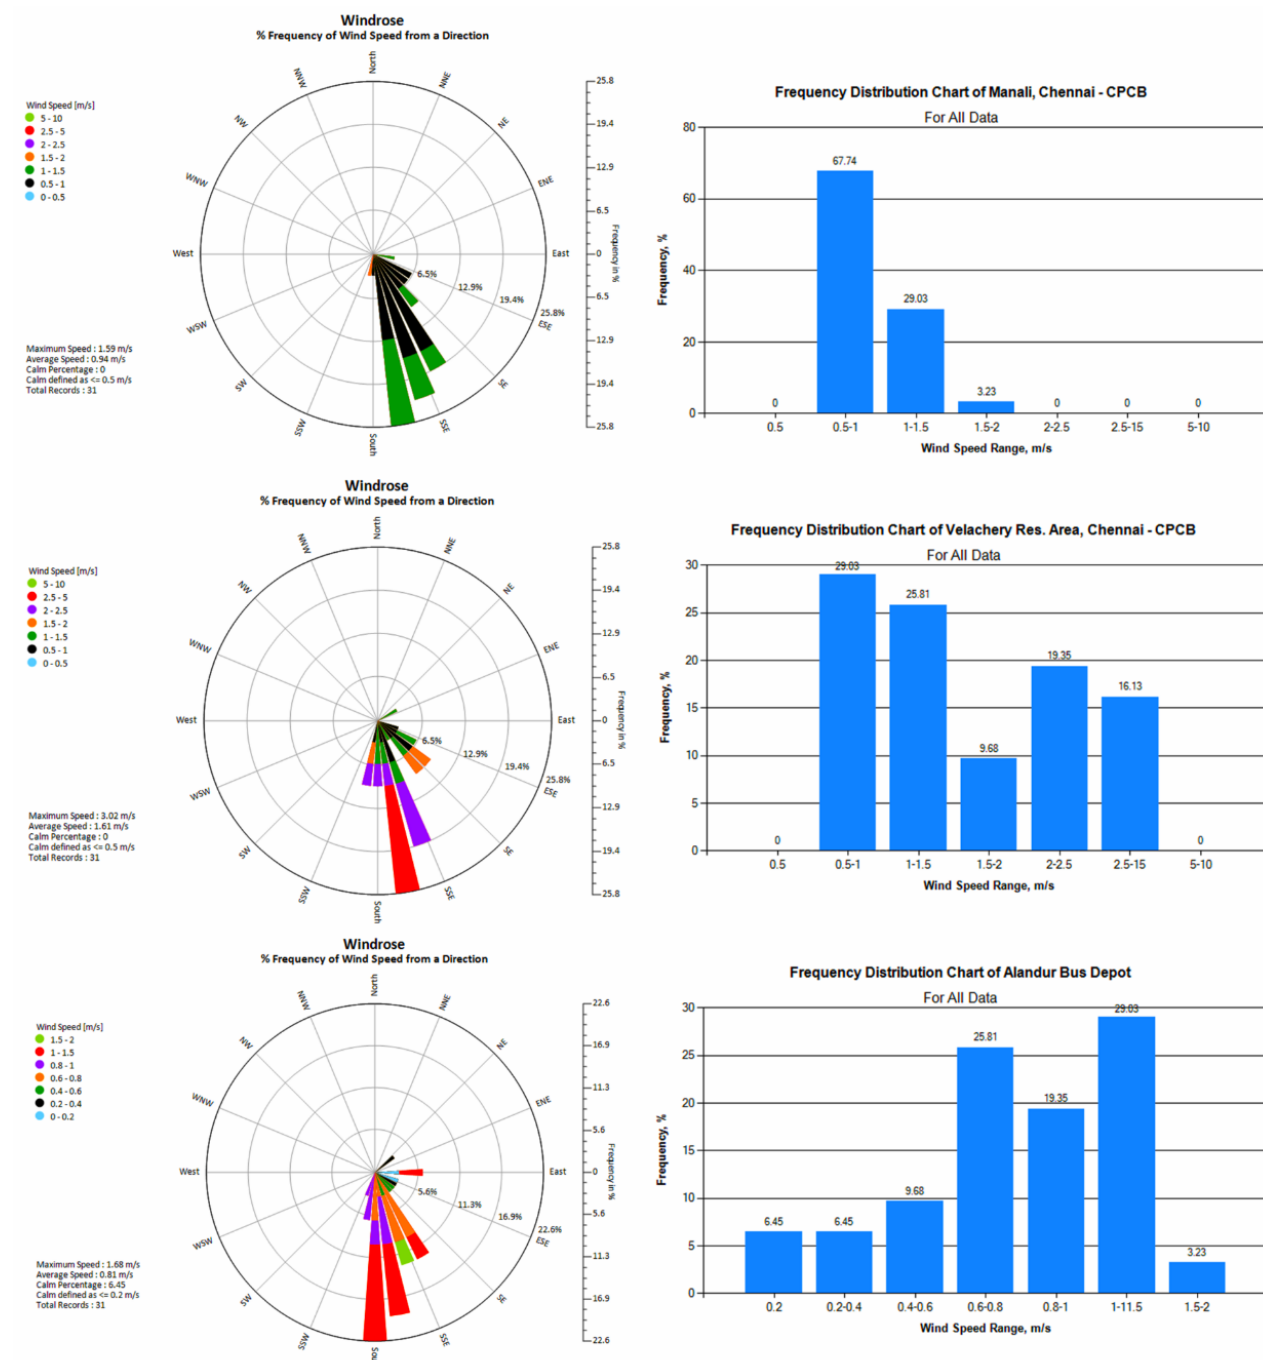
Figure 8. The wind rose and frequency distribution chart of the Manali-Industrial area, Velachery- Residential area, and Alandur Bus Depot-Traffic/Roadside area in Chennai metropolis.